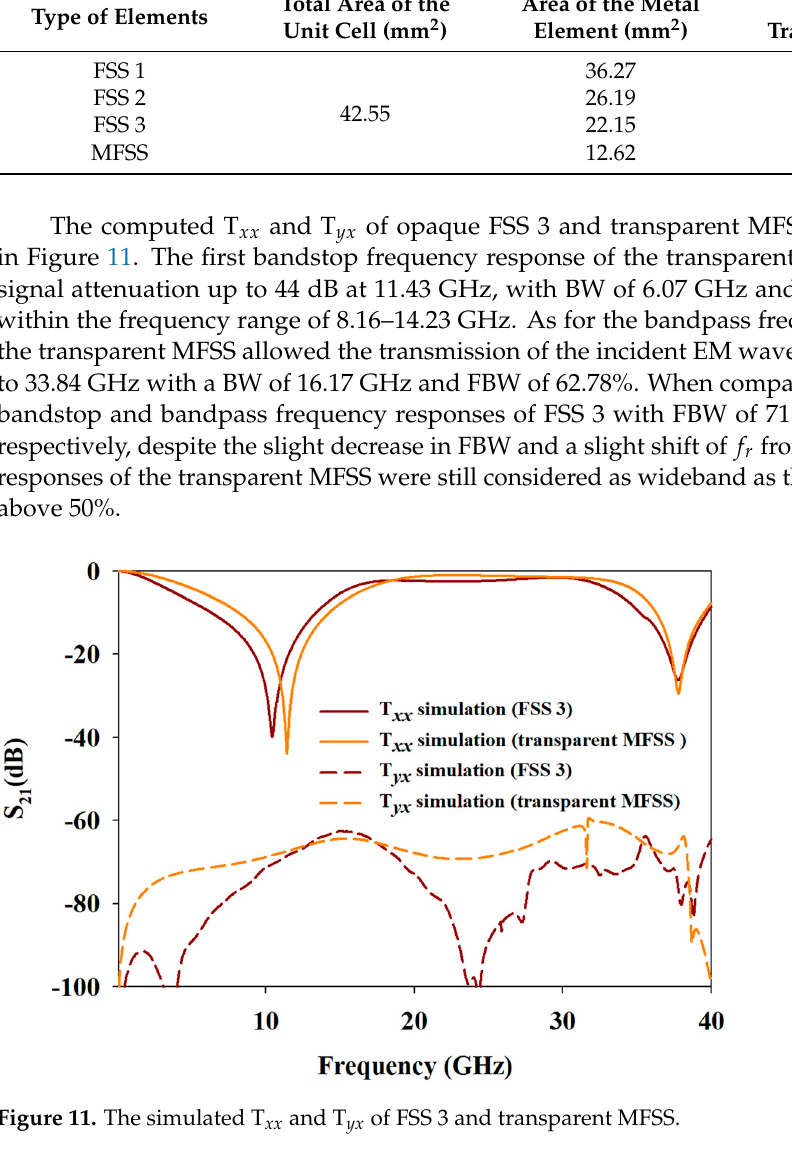
Figure 12. Simulated responses of transparent MFSS under the influence of oblique angle variations of ( a ) TE mode and ( b ) TM mode